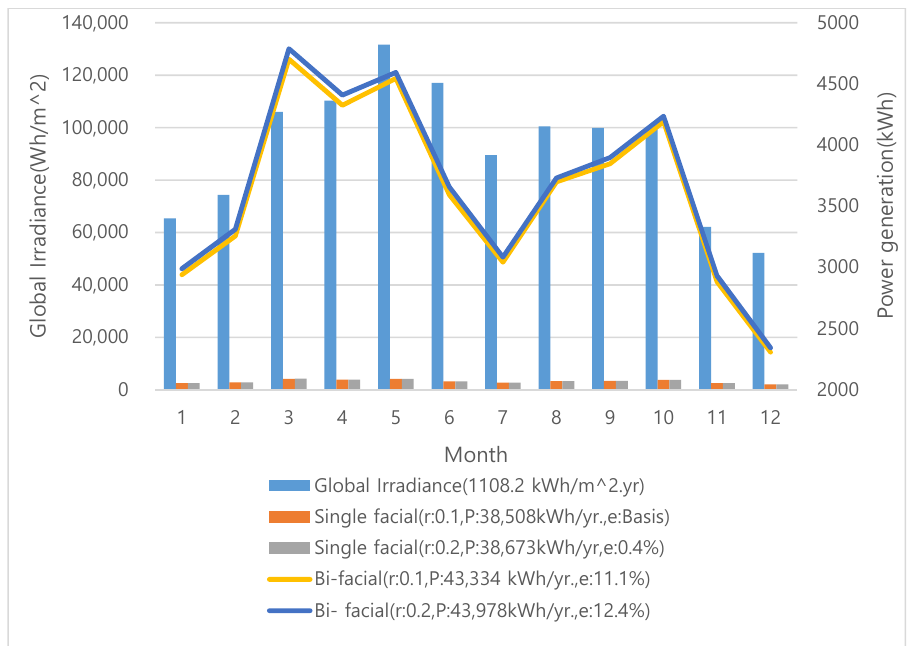
Figure 9. T he power generation depending on PV module type and reflectance of the PV cell. Figure 9. The power generation depending on PV module type and reflectance of the PV